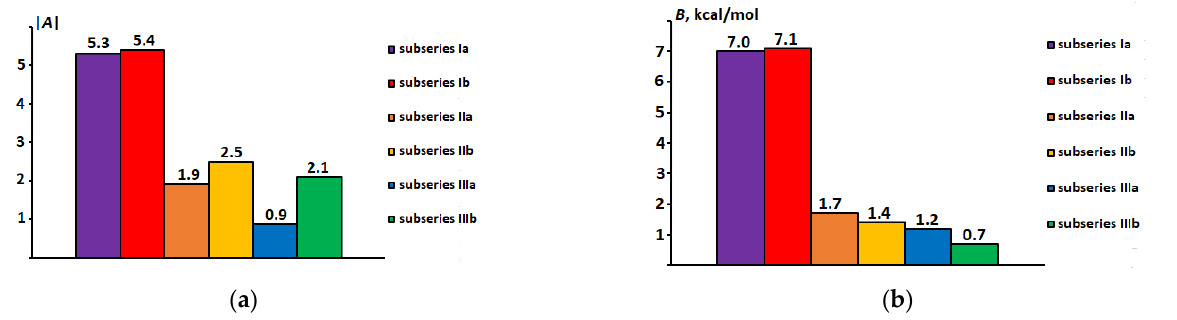
Figure 8. Slope A ( a ) and intersection point B ( b ) in equations − E π (PPE) = A × σ p + B for subseries of compounds with different bridges: subseries Ia,b; IIa,b and IIIa,b —double bond, para-phenyl ring, and meta-phenyl ring, respectively, as the π -bridge. The R 1 substituent is fixed and the R 2 substituent varies in part a of the subseries, the R 2 substituent is fixed and the R 1 substituent varies in part b of the subseries.